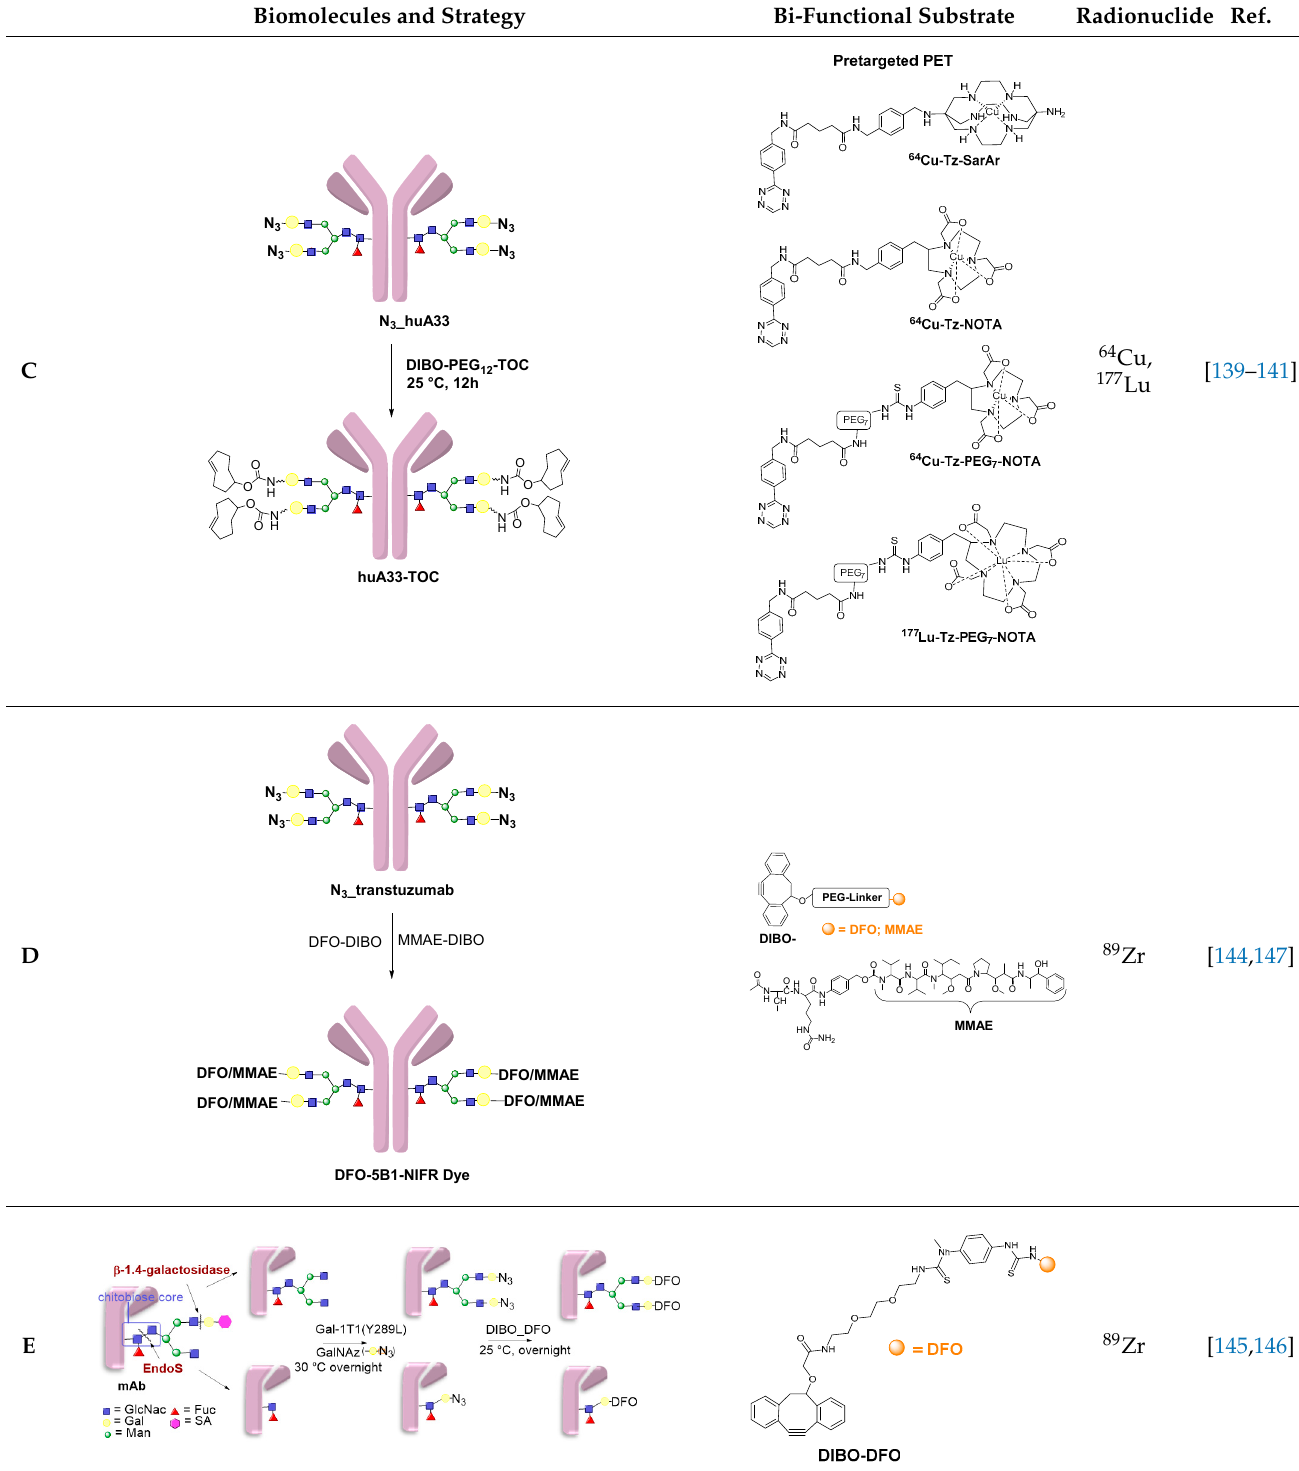
Table 7. Cont. Biomolecules and Strategy Bi-Functional Substrate Radionuclide